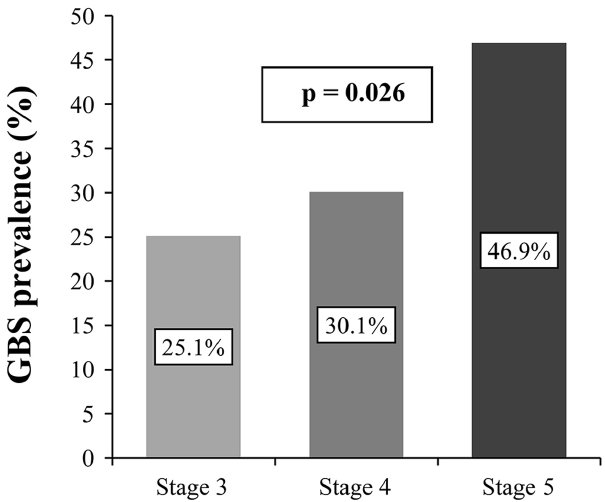
Figure 1. Prevalence of gallbladder stone (GBS) according to chronic kidney disease stage (95% CI: 24.3-32.3; P = .026, Pearson’s chi-square